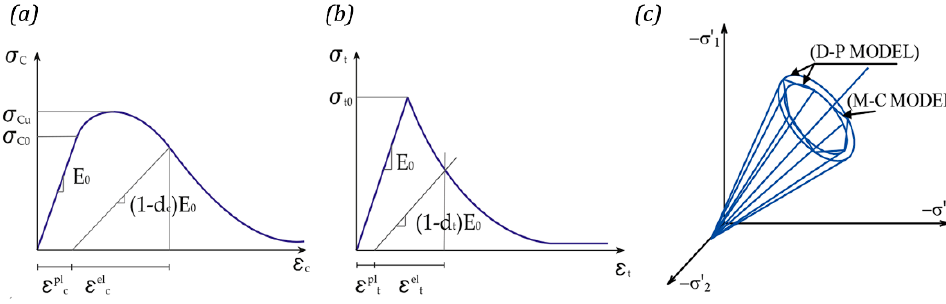
Figure 4. Inelastic mono axial curve in compression ( a ) and tension ( b ), and yield surface in the Westergaard space ( c ).